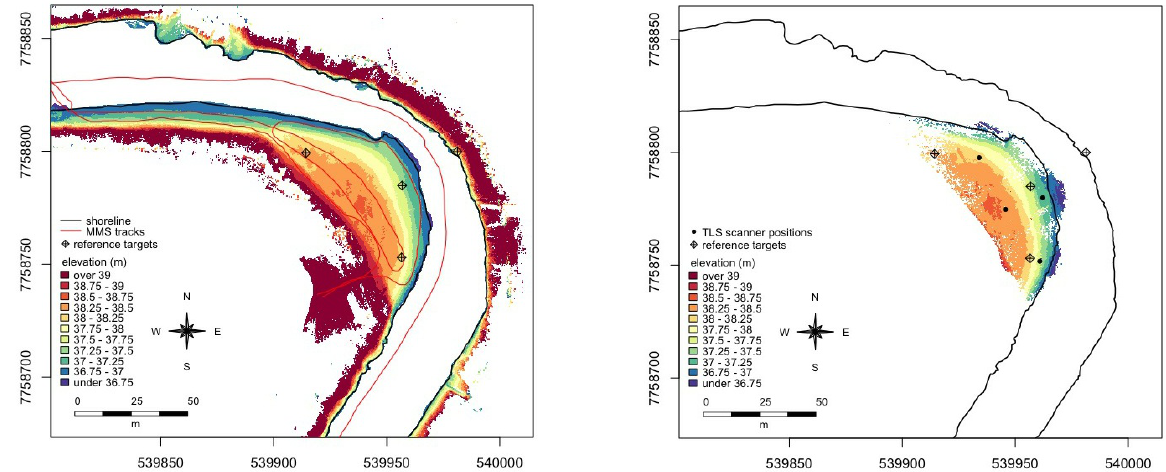
Figure 3. Mobile LiDAR point cloud of 2011 ( left ) and TLS reference point cloud 2011 ( right ) coloured by